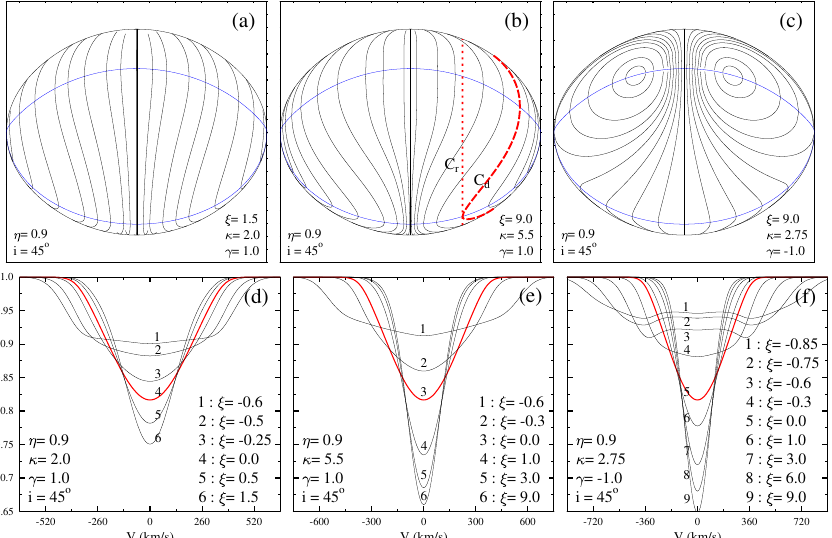
Figure 26. Upper series: Curves of constant radial velocity C contributing to the rotational Doppler broadening of spectral lines. ( a ) C curves for a Maunder-like surface angular velocity law with ∂ Ω ( θ ) / ∂θ > 0; ( b ) C curves for a law given by Equation (45) with γ > 0, so that ∂ Ω ( θ ) / ∂θ > 0; ( c ) C curves for a law given by Equation (45) with γ < 0, so that ∂ Ω ( θ ) / ∂θ < 0. In cases ( a , b ), the largest Doppler displacement is produced in the limb at the equator, while in case ( c ), the largest Doppler displacement is produced in the center of the upper closed curves. Case ( b ) identifies the lines producing the same Doppler displacement, C r = C d , where C r (red dotted line) indicates a rigid surface rotation, and C d (red-dashed line) a differential surface rotation. In all cases, the parent Doppler displacement from rigid rotation is determined by the straight line touching the corresponding C d curve at the equator. Lower series: Gaussian line profiles broadened by rotation, whose intensity and equivalent width depends on the effective temperature and gravity such as a HeI4471 transition: ( d ) line profiles for the curves of constant radial velocities of the type shown in ( a ) for several parameters ξ in Equation (45); ( e ) line profiles are for the constant radial velocities shown in ( b ) for several parameters ξ ; ( f ) line profiles are for the constant radial velocities shown in ( c ) for several parameters ξ . Calculations include gravitational darkening. The parent non-rotating object has T eff = 22,000 K and log g = 4.0. The angular velocity law is given by Equation (45) with the same parameters ( κ , γ , η , i ) as in the corresponding upper blocks, except that ξ takes a wider range of values. In all cases, ξ = 0 represents the rigid rotation and the corresponding line profile is red-highlighted. In all blocks, the ordinates are the same. Adapted from Zorec et al.